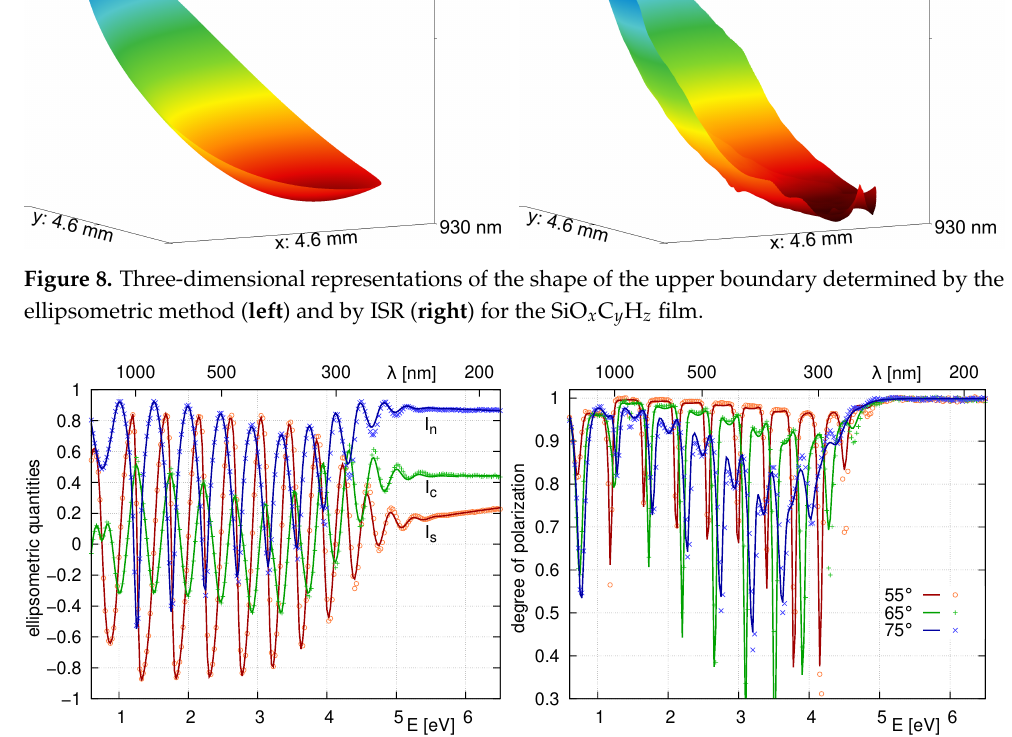
Figure 9. Agreement between the experimental and theoretical values for the associated ellipsometric parameters of the SiO x C y H z film at incidence angle 70 ◦ ( left ) and the degree of polarization at three selected angles of incidence ( right ). The plots correspond to azimuth angle β = 0 ◦ . The points represent the experimental values while the lines represent the theoretical